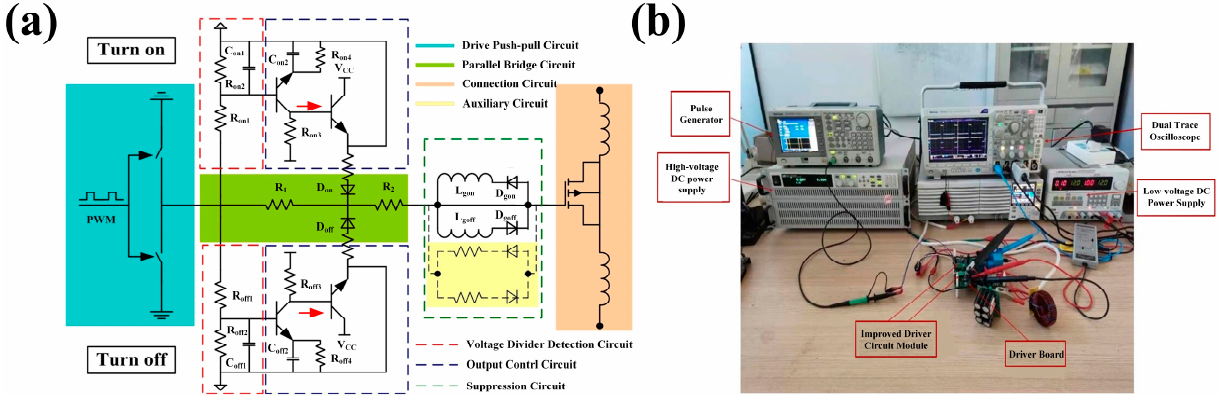
Figure 6. The design of the improved double-pulse platform: ( a ) circuit model and ( b ) experimental system.